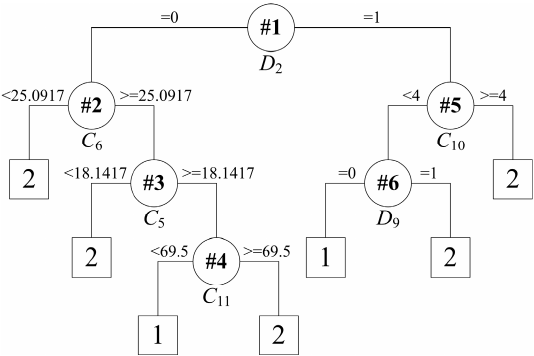
Figure 8. Tree structure for rule extraction on the original training